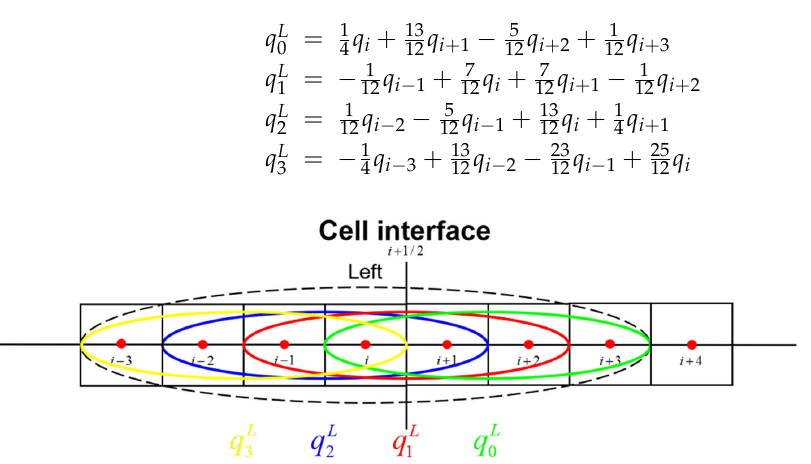
Figure 3. Sketch of a 7 ‐ point stencil for computing the left primitive variables.